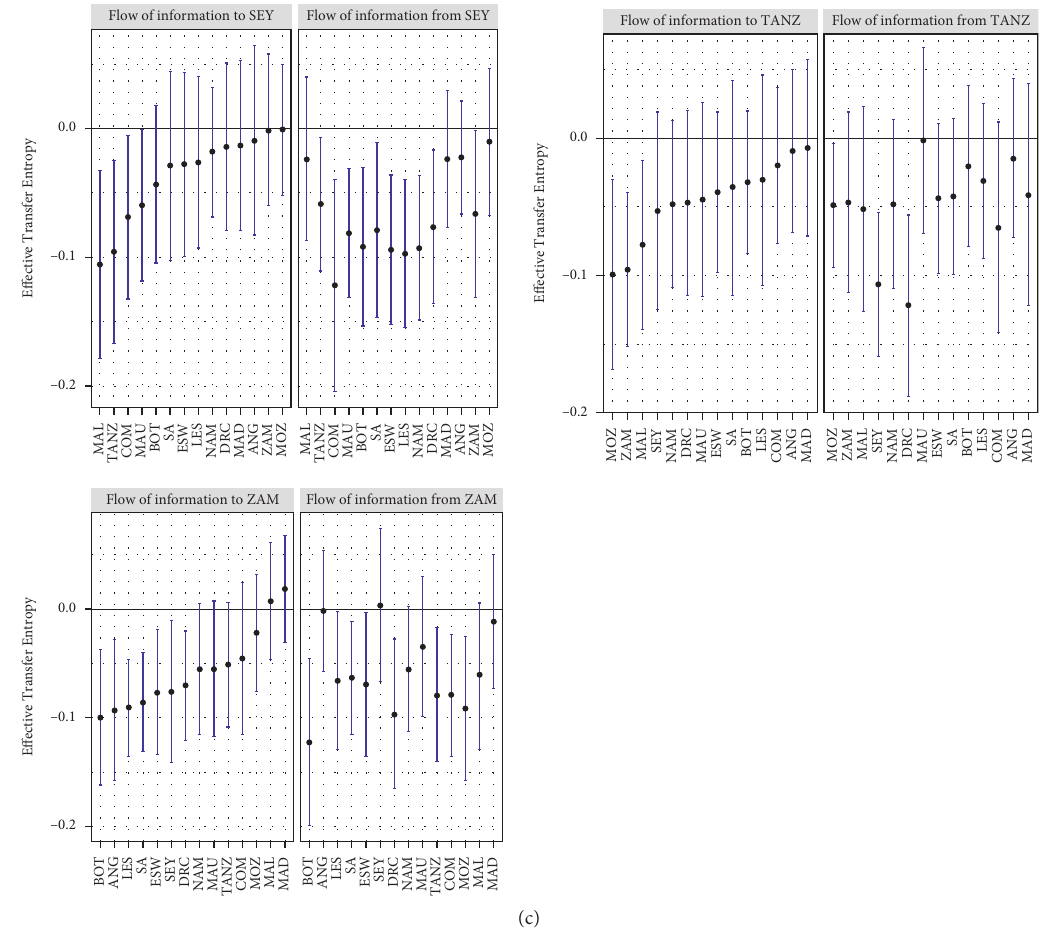
Figure 3: Information flow between exchange rates at medium frequency